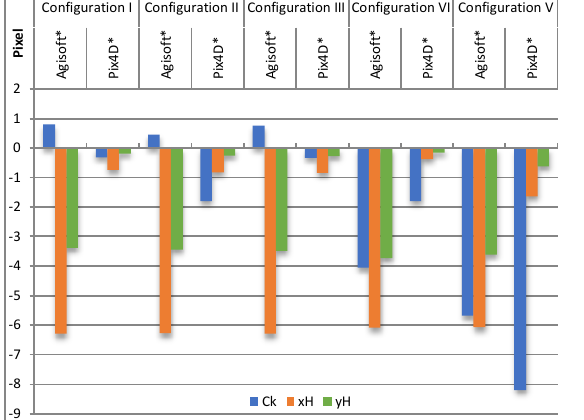
Figure 17: Deviation of focal length and principal point between self-calibration and test field calibration for each